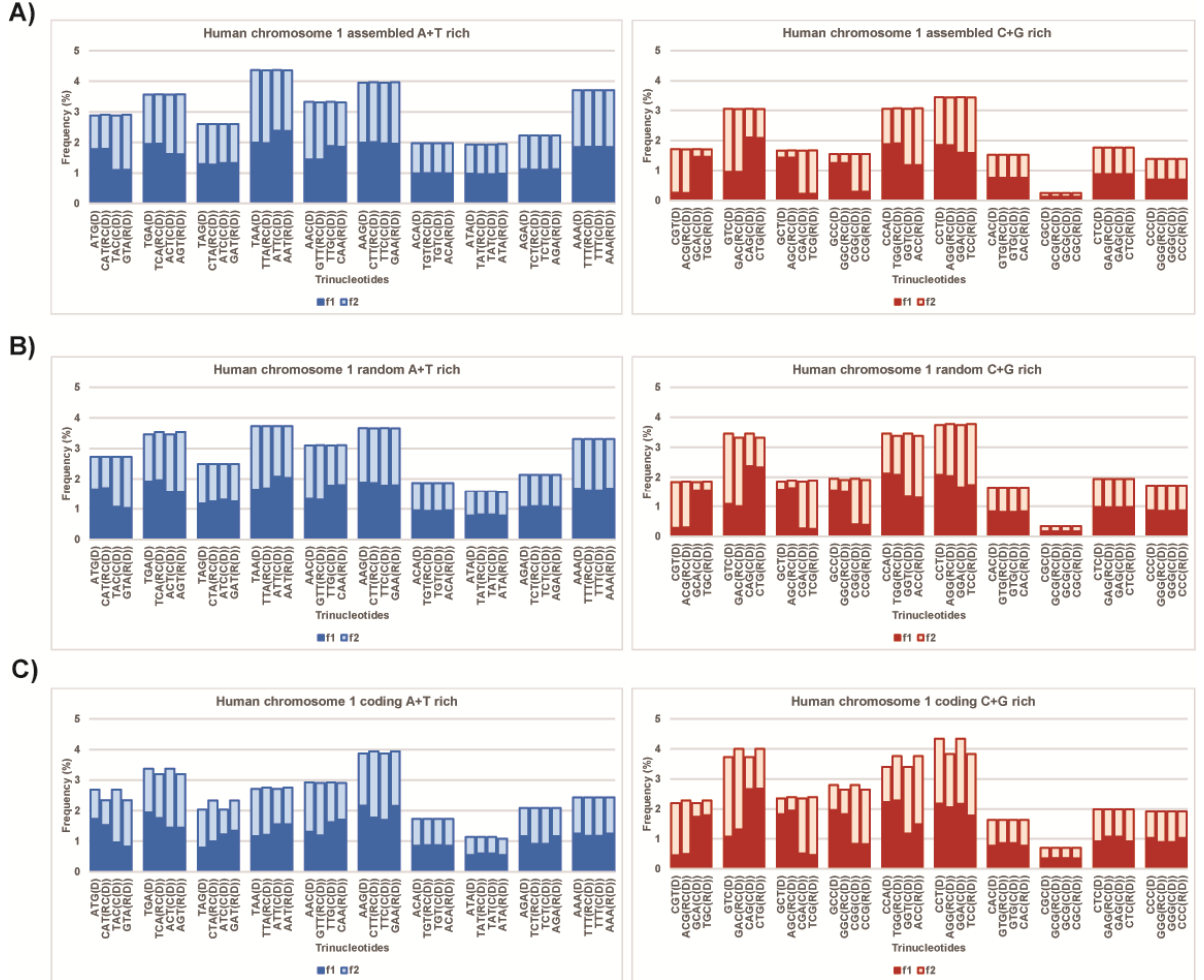
Figure 3. A-T-rich and C-G-rich trinucleotide quadruplet matrices of human chromosome 1. ( A ) In each quadruplet, the frequency of all four members (D, RC, C and R) in both strands is practically identical (for numerical values, as reflected in the plateau on the upper edge of each quadruplet. The plateau shows that the investigated sequence (chromosome, genome) is in accordance with CSPR. ( B ) Quadruplet matrices in random sequences of 200,000 bp. A concatemer of 1000 randomly selected 200 bp subsequence from human chromosome 1 shows very small deviations in some quadruplets (smaller than 1%), which is reflected by a slightly indented plateau, showing approximate agreement with CSPR. ( C ) Quadruplet matrices for concatenated coding sequences longer than 17,000,000 bp of the same chromosome show significant deviations in frequencies and no agreement with CSPR, especially for asymmetric trinucleotides. Instead of a plateau, the frequency for D and C differs from the frequency for R and RC, only because of Watson–Crick